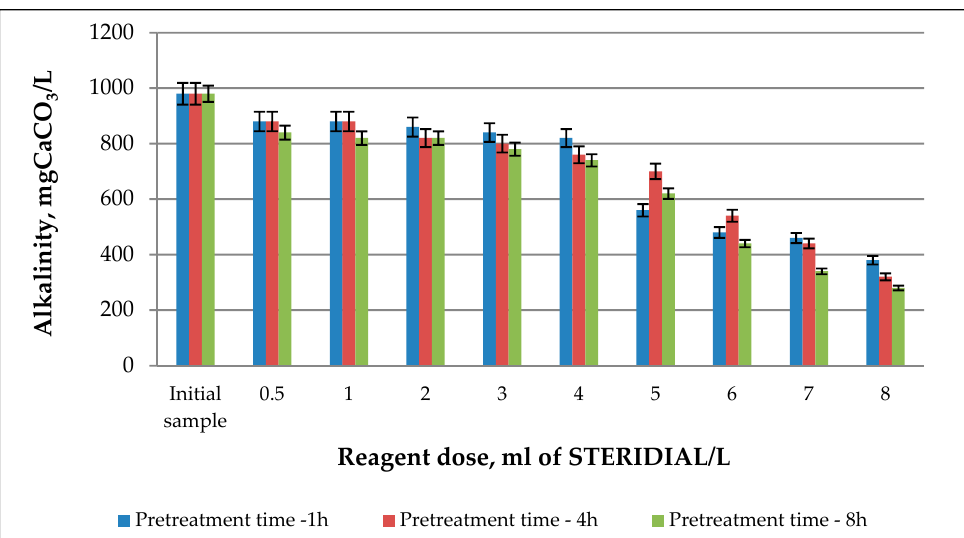
Figure 4. Changes in acidity determined in the sludge liquor subjected to 1, 4, and 8 h chemical disintegration of excess sludge vs. reagent dose.